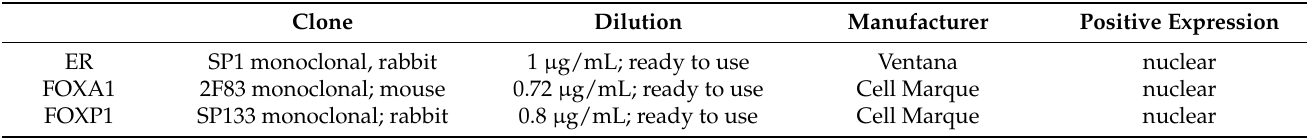
Table 1. The antibodies